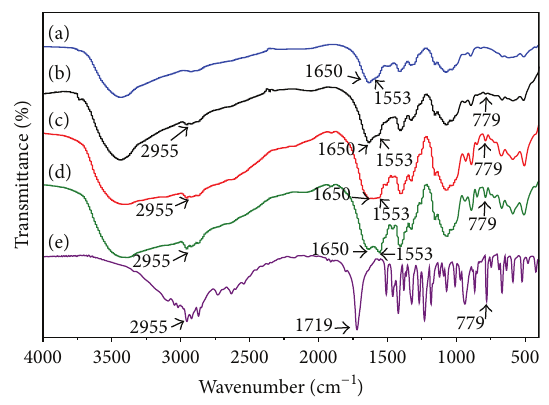
Figure 3: FT-IR spectra of the chitosan hydrogels with different concentrations of ibuprofen. Chitosan (a); chitosan with 0.2% ibuprofen (b); chitosan with 0.6% ibuprofen (c); chitosan with 1.0% ibuprofen (e); and ibuprofen (d).